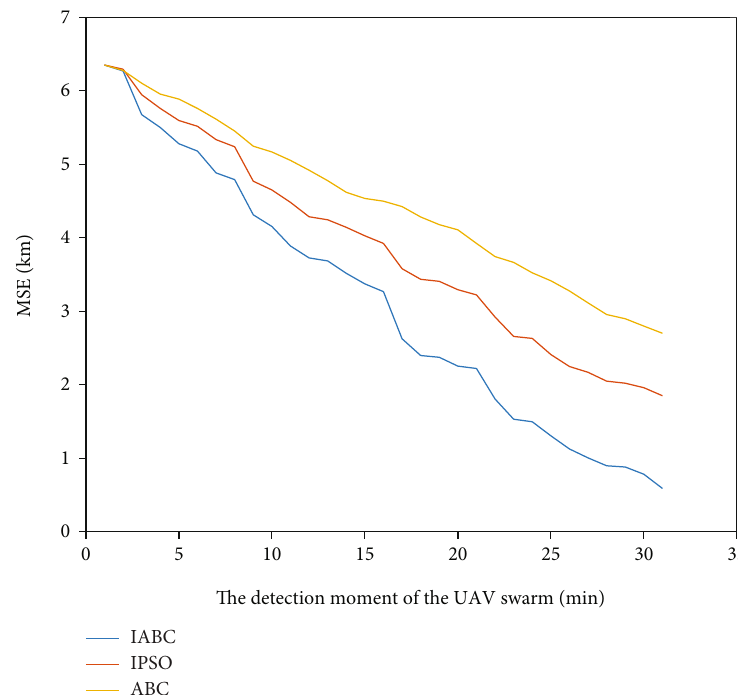
Figure 9: MSE comparison of di ff erent optimization